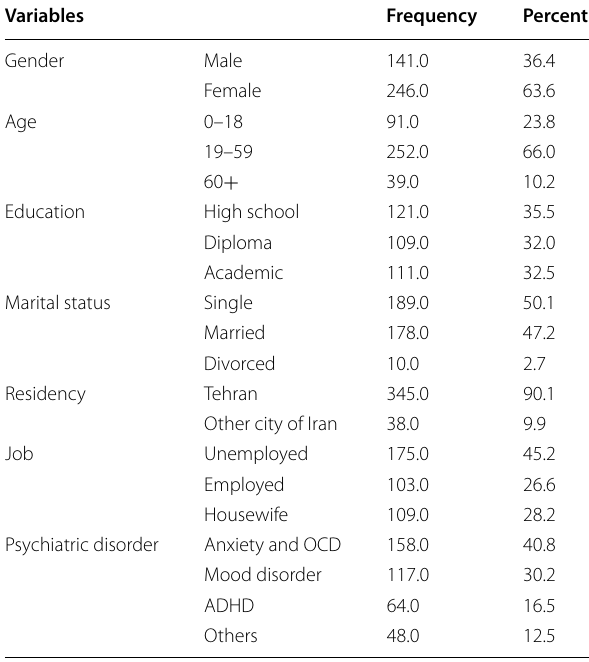
Table 1 Demographic characteristics of study